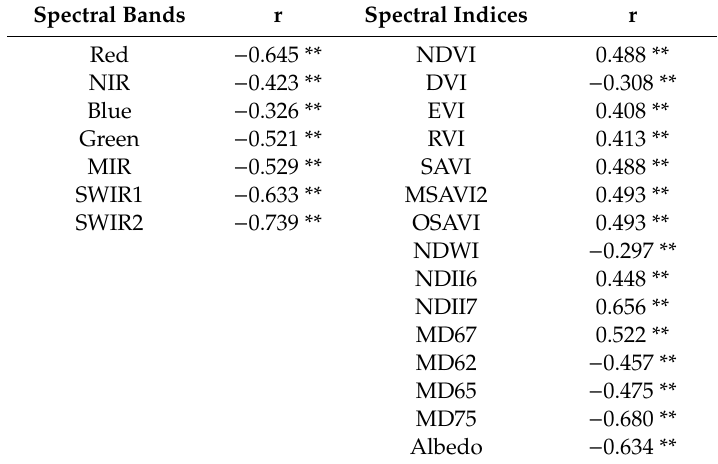
Table 4. Correlation coe ffi cients (r) between MODIS variables and aboveground carbon density.